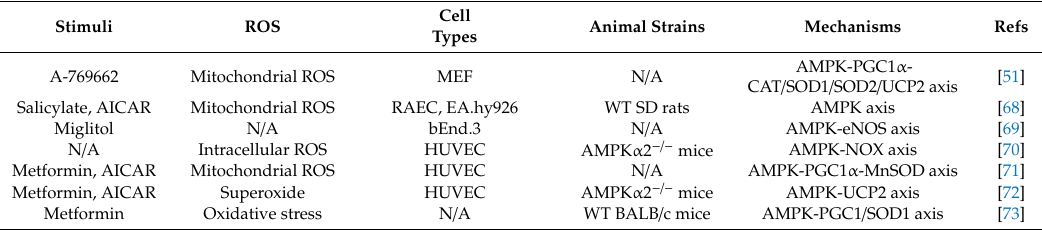
Table 2. Activation of AMPK suppresses oxidative stress. AICAR, 5-aminoimidazole-4-carboxamide ribonucleotide; WT, wild-type; SD, Sprague Dawley; SOD, superoxide dismutase; CAT, catalase; UCP, uncoupling protein; NOX, nicotinamide adenine dinucleotide phosphate oxidase; PGC, peroxisome proliferator-activated receptor gamma